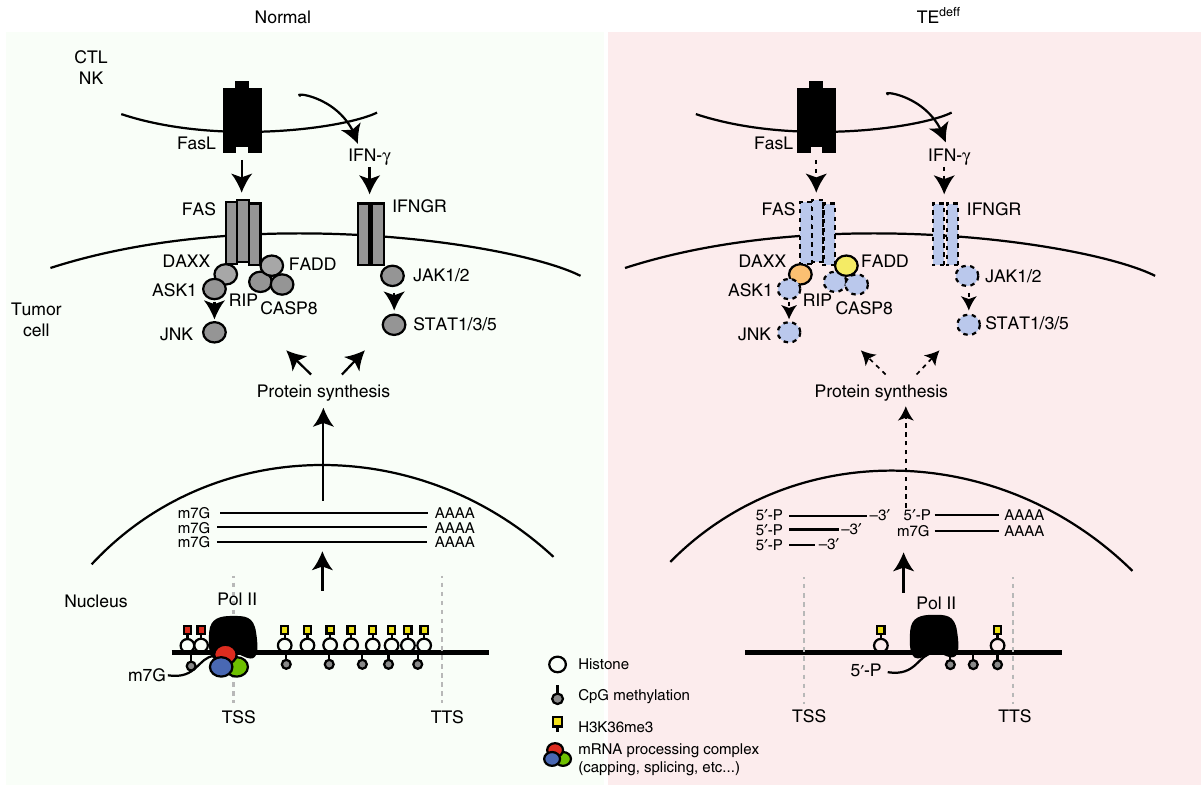
Fig. 8 A model of TE deff -induced immunotherapy resistance. Intact transcriptional fi delity is essential for the baseline and cytokine (e.g. IFN)-inducible expression of the in fl ammatory response pathways that prime the tumor cell for cytolytic cell attack (left). However, in TE deff cells, transcription elongation defects lead to the expression of spurious transcripts and poor nuclear export of the in fl ammatory response pathway genes. This, in turn, severely reduces the sensitivity of the tumor cell to the cytolytic T and NK cell-mediated anti-tumor mechanisms